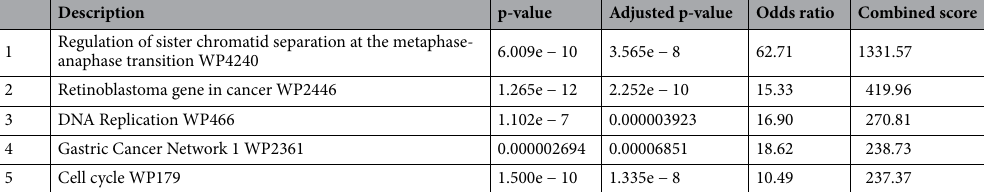
Table 5. Wikipathway up-regulated DEGs enrichment analysis.